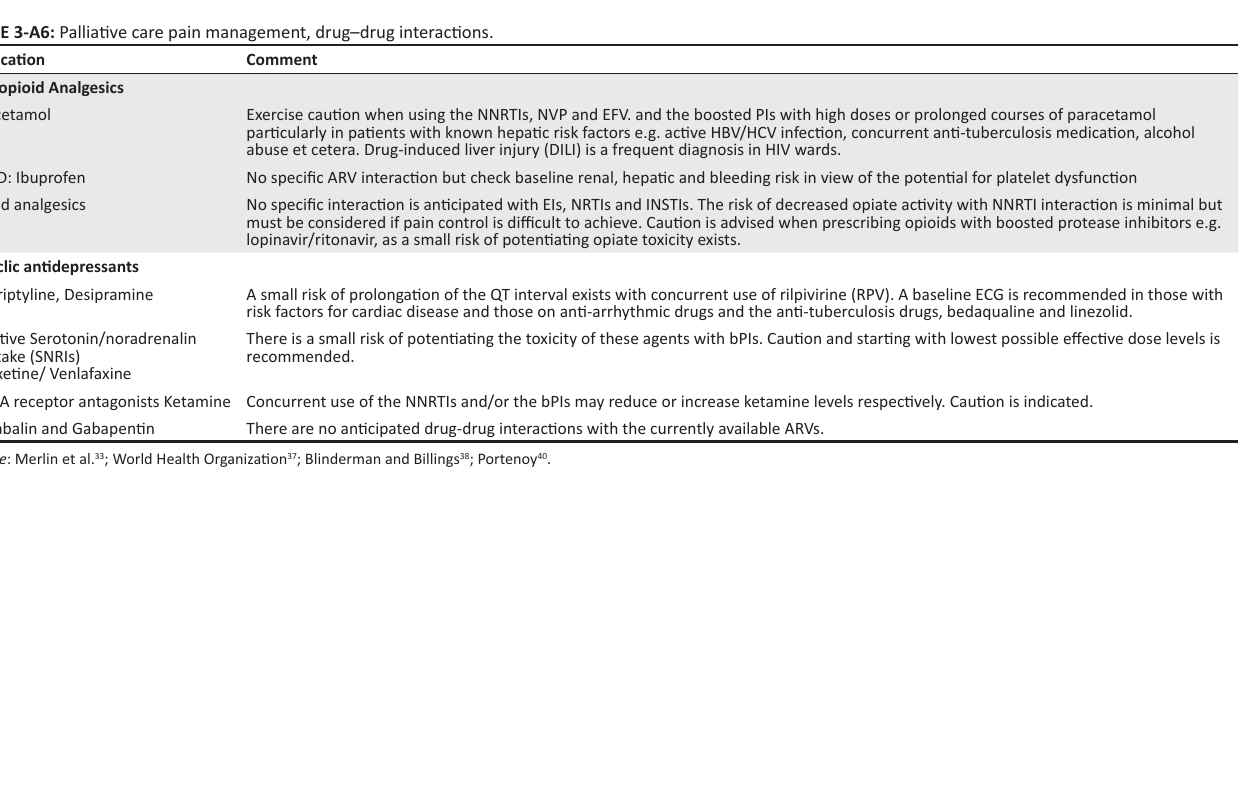
TABLE 2-A6: Palliative care seizure management, drug–drug interactions. Drug Advantage Carbamazepine